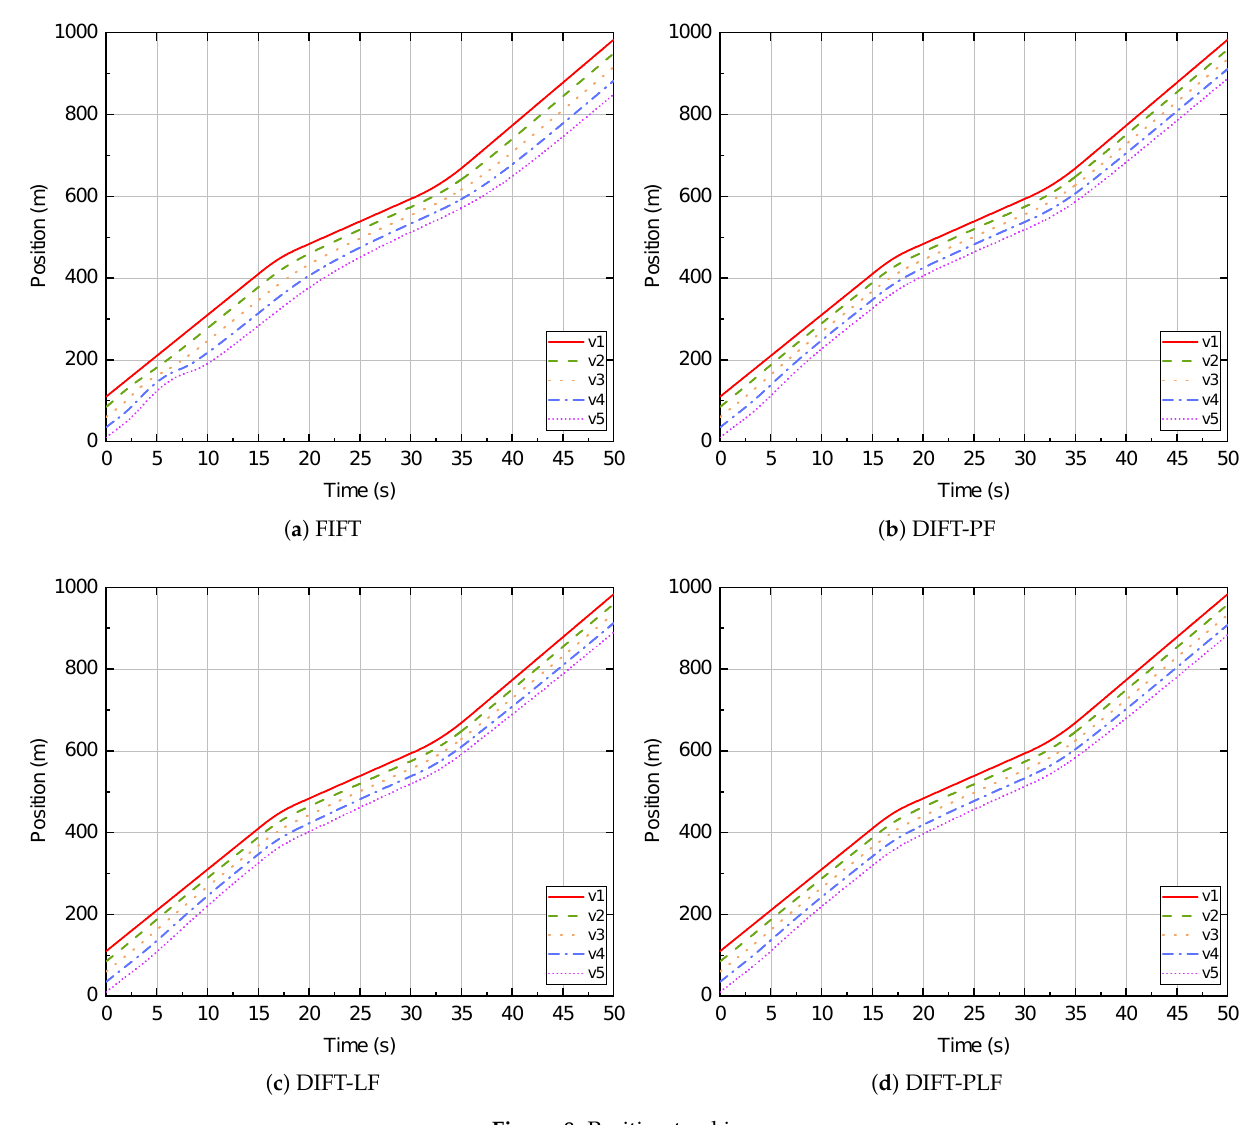
Figure 8. Position